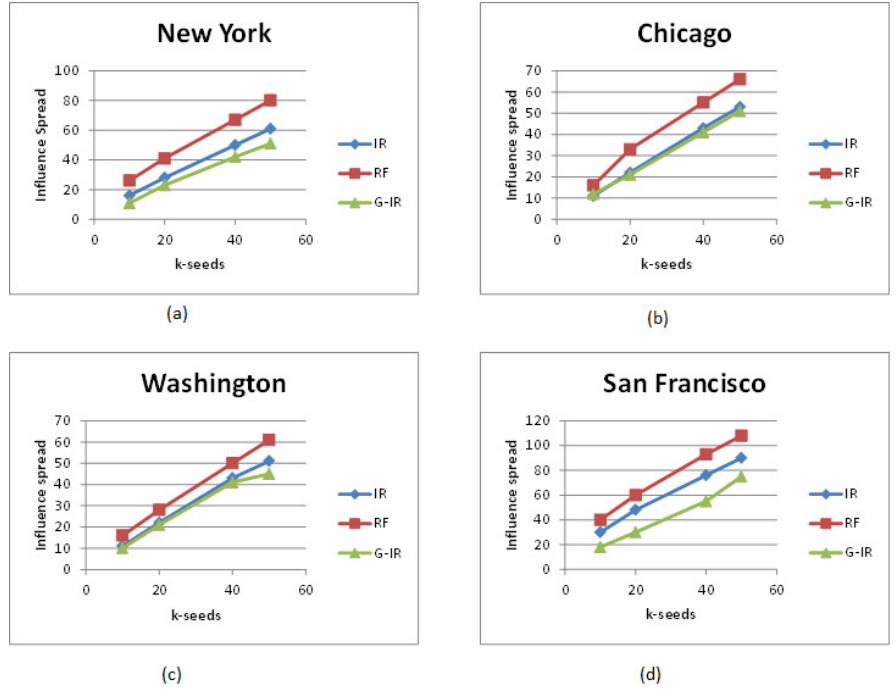
Figure 4. Influence spread on various regions on Foursquare